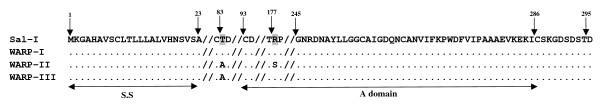
Amino acid sequence alignment of the three pvwarp variants in 50 Iranian P. vivax isolates. The sequences were compared with Sal-I ([GenBank: XM-001608555] and represent the secretary signal sequence (SS), the A domain. The representative PvWARP haplotypes are: PvWARP-I (T/R, 8%), PvWARP-II (A/S, 88%) and PvWARP-III (A/R, 4%). //, indicates conserved sequences and dots represent identical residues.